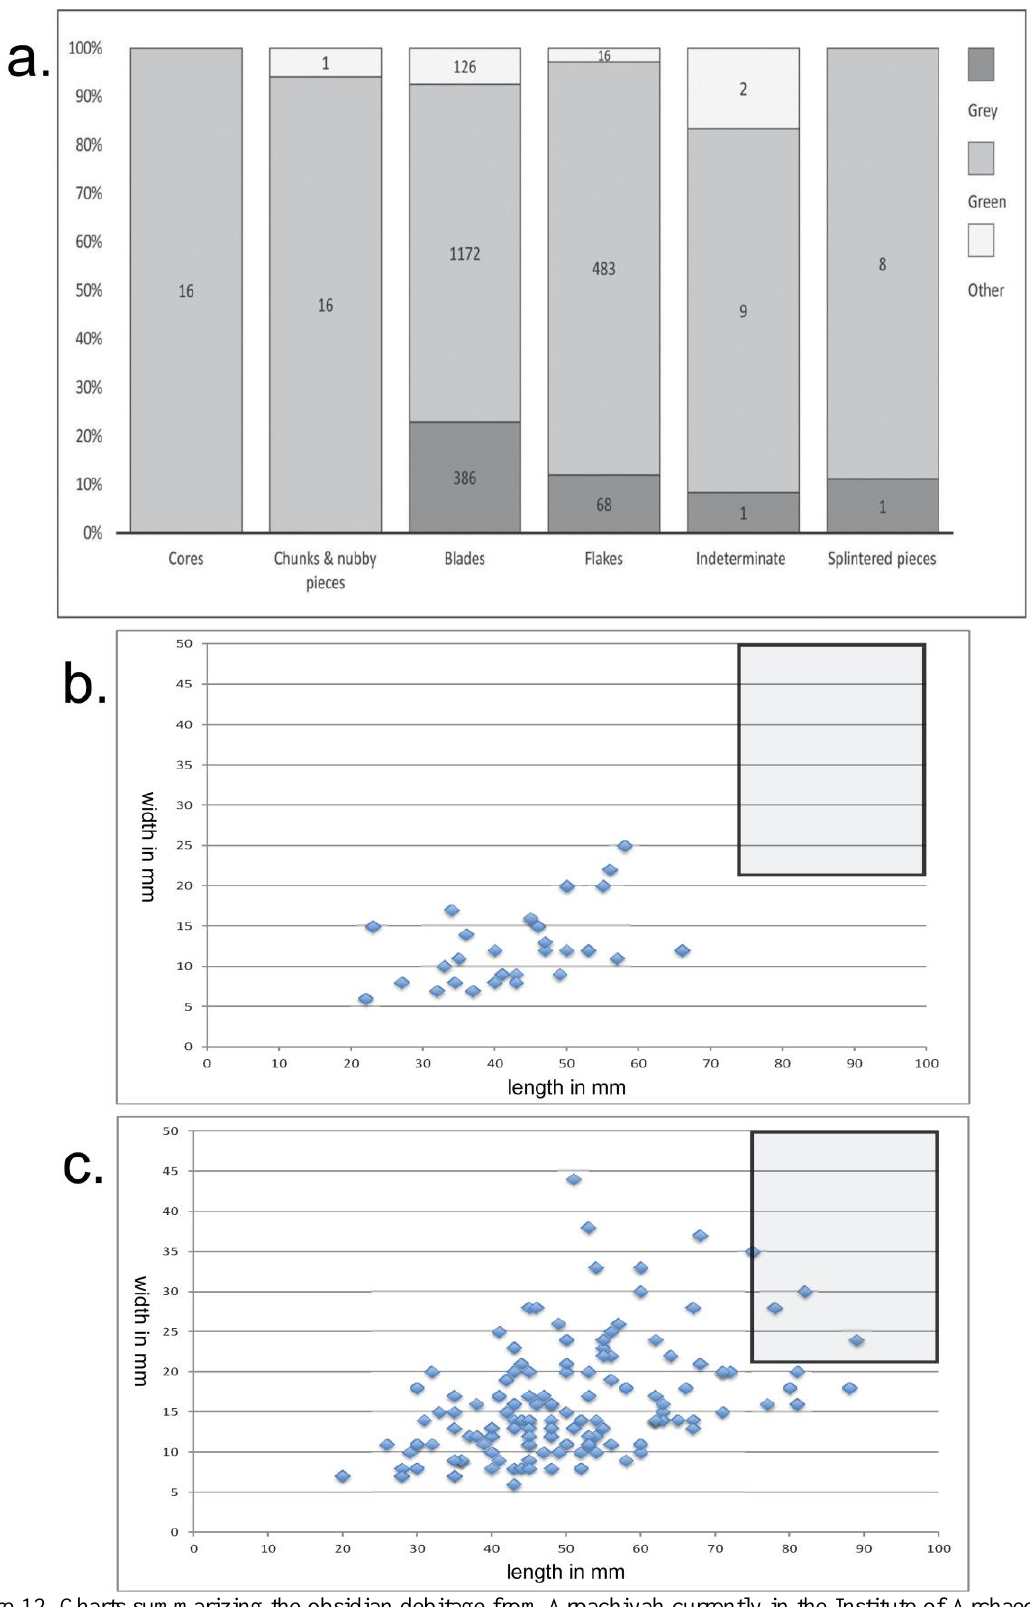
Figure 12. Charts summarizing the obsidian debitage from Arpachiyah currently in the Institute of Archaeology in London: a. by type and colour. b. & c. scattergram showing the length and width of complete grey and green blades; inset rectangles show estimated size of blank required to make rectangular links (b. obsidian, c. green obsidian) (source Stuart Campbell and Elizabeth